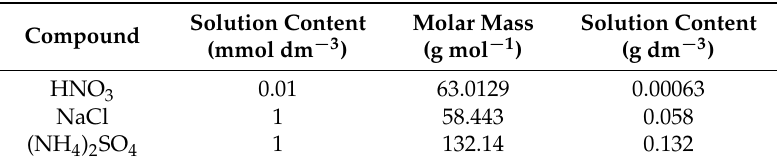
Table 4. Chemical composition of simulated acid rain